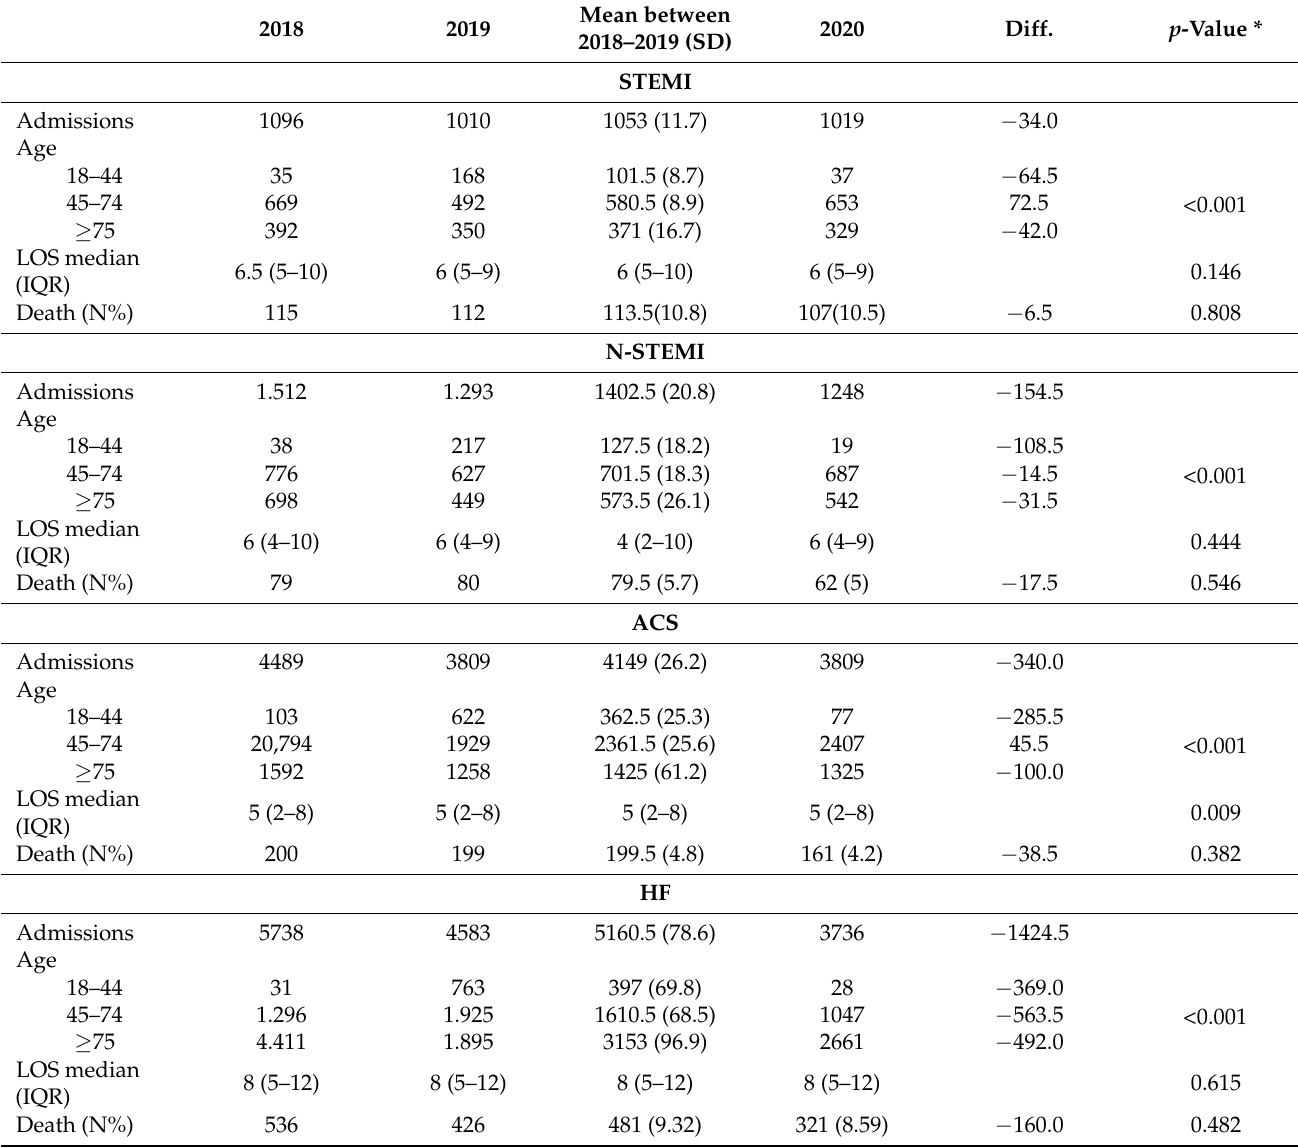
Table 1. Comparison of admissions that occurred between 2020 and the mean of the years